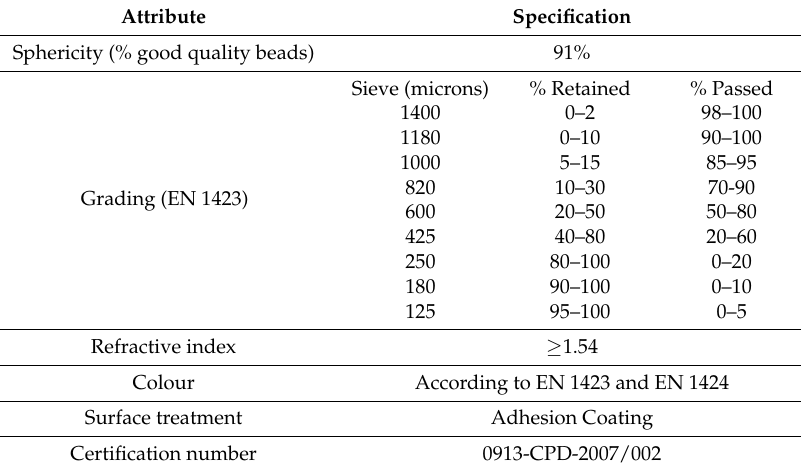
Table 7. Duolux 121 H1 glass microbeads